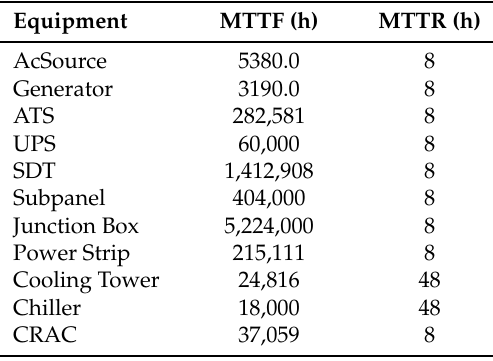
Table 1. MTTRand